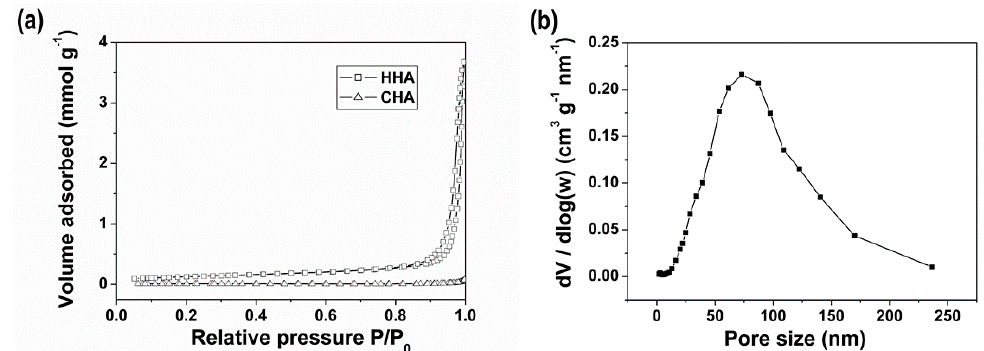
Figure 2. ( a ) Nitrogen sorption isotherms of HHA and CHA scaffolds; ( b ) the BJH-adsorption pore size distribution of the HHA scaffold.